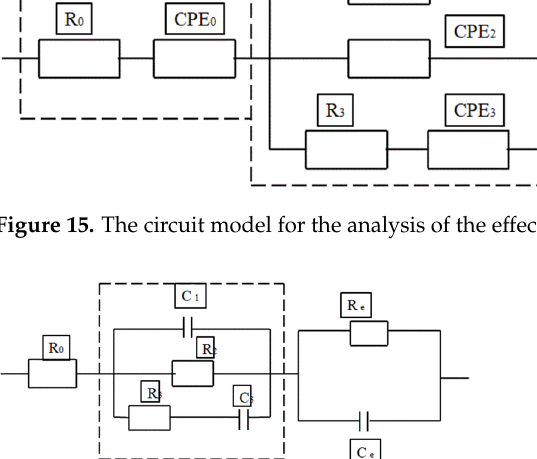
Figure 16. The circuit model for the analysis of chloride migration